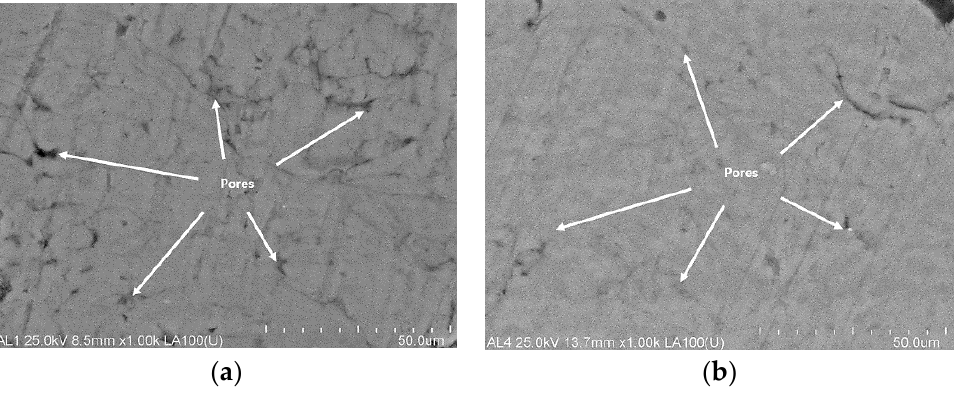
Figure 3. SEM images of Al coatings using ( a ) HPCS and ( b ) LPCS.